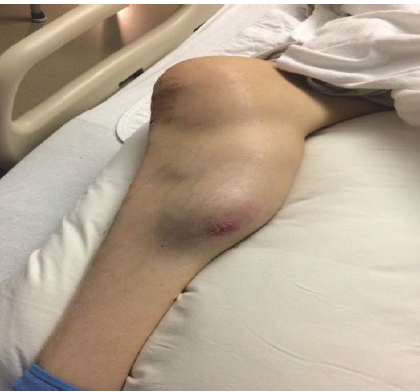
Figure 1: Patient’s Right leg at presentation. Erythema and swelling are noticeable on the medial aspect.